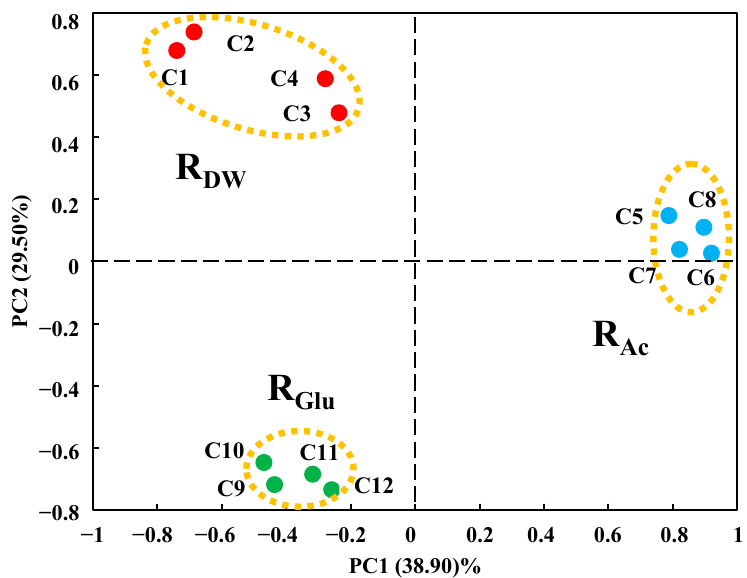
Figure 3. Principal component analysis (PCA) of microbial communities from different electron donor sources feeding BESs.